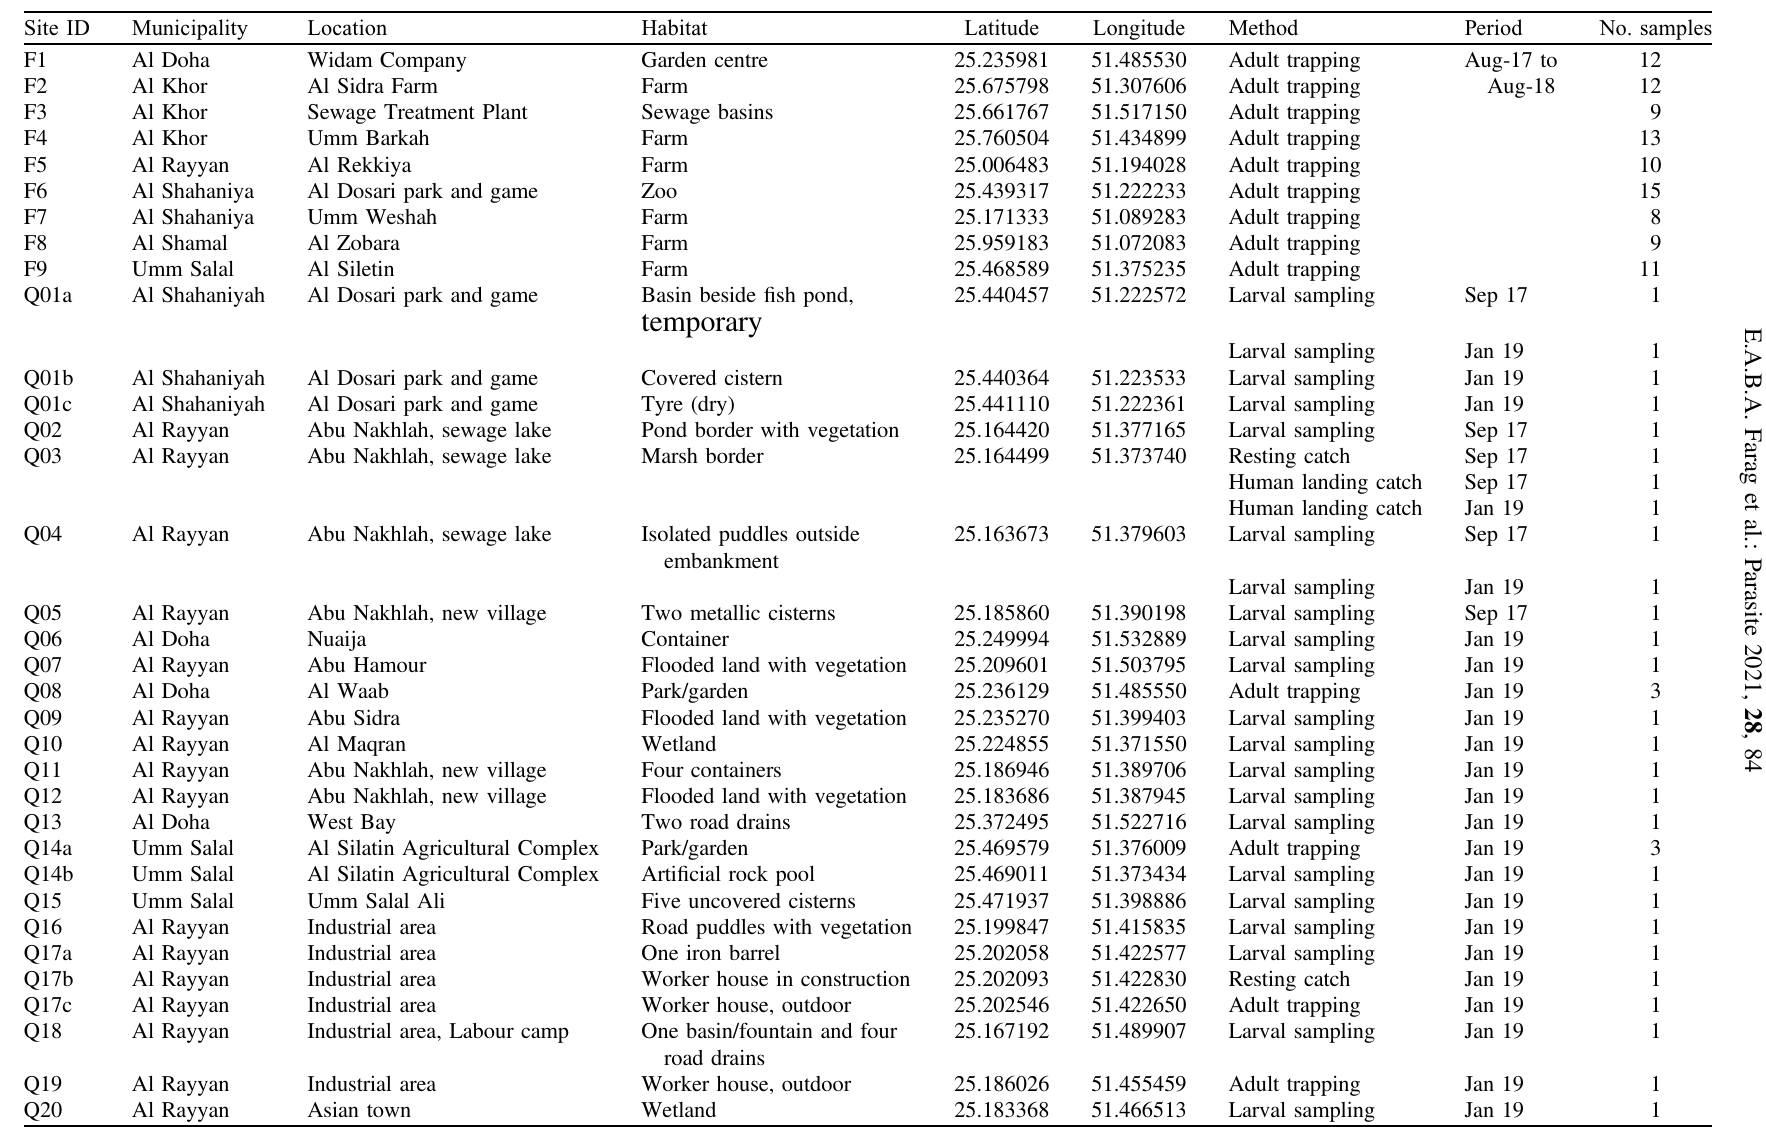
Table 1. Location and characteristics of sampling sites [F1 – F9: Longitudinal survey, session 1; Q01 – Q20 Field surveys, session 2 (September 2017) and 3 (January 2019)], with sampling method, period, and number of samples